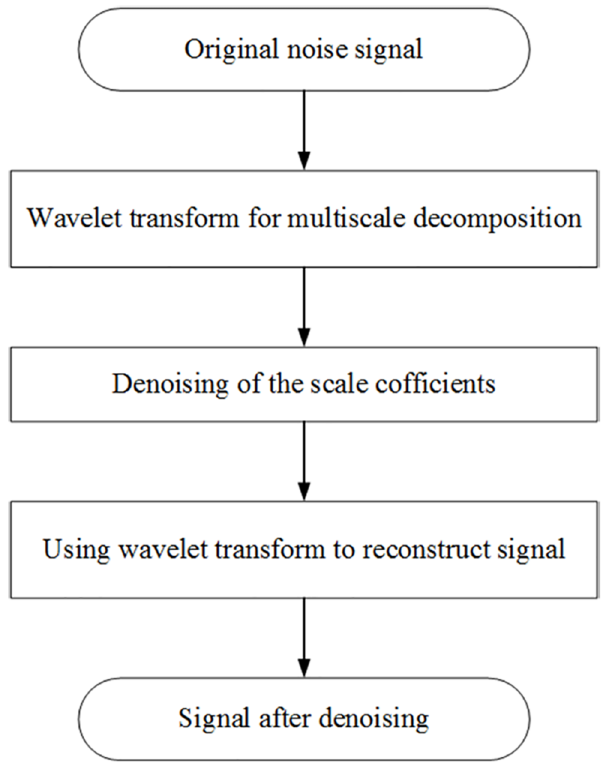
Fig 2. Flow chart of wavelet denoising. The principleis that the wavelet coefficientsof the originalsignal are processedby using the threshold value function. The threshold function reflects whetherthe signal is aboveor below the threshold of the wavelet coefficients with respect to different processingstrategies, and accordingto different spacecraft electrical characteristic data, hard or soft thresholdfunctions are used to obtain a better filtering denoisingeffect. The flow chart of wavelet denoisingis shown as Fig 2.